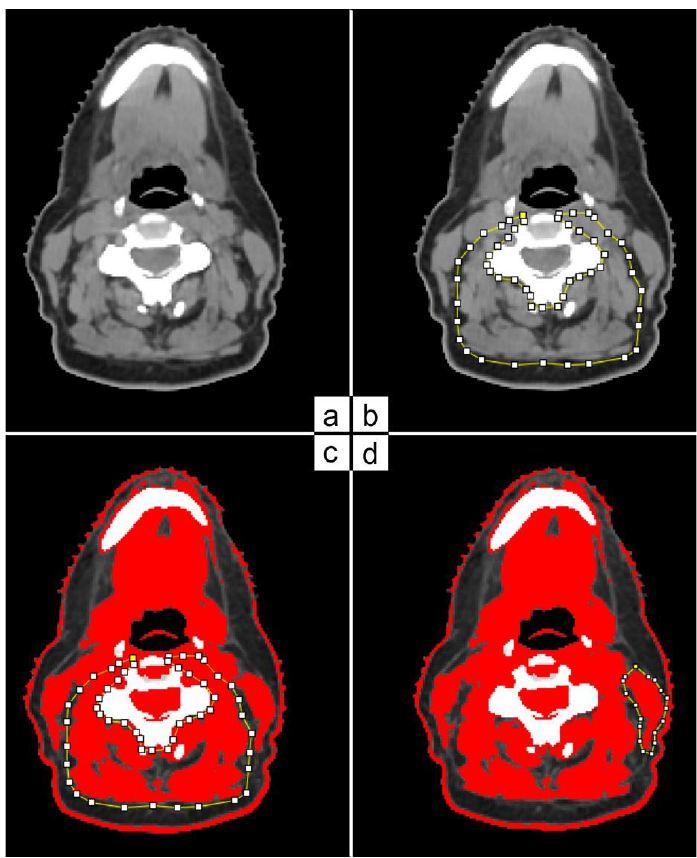
Figure 1. C3 paravertebral and SCM area delineation on CT scan based on HU threshold .